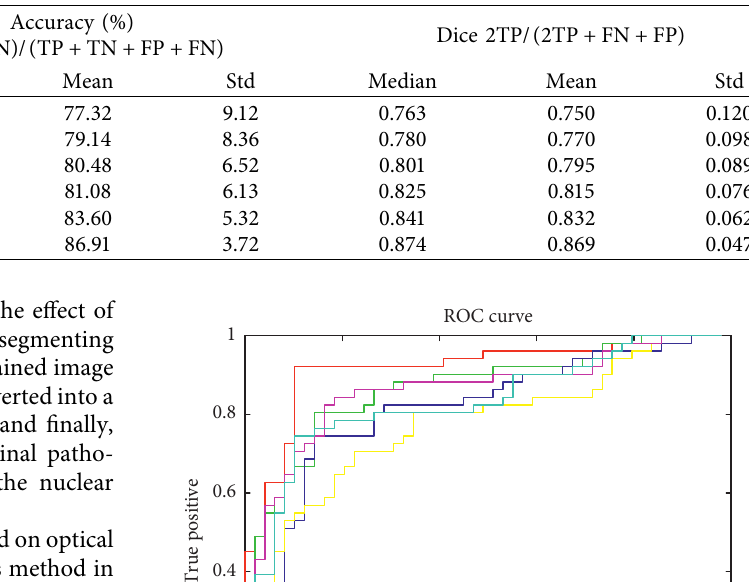
Table 2: Comparing results with the state-of-the-art algorithms.